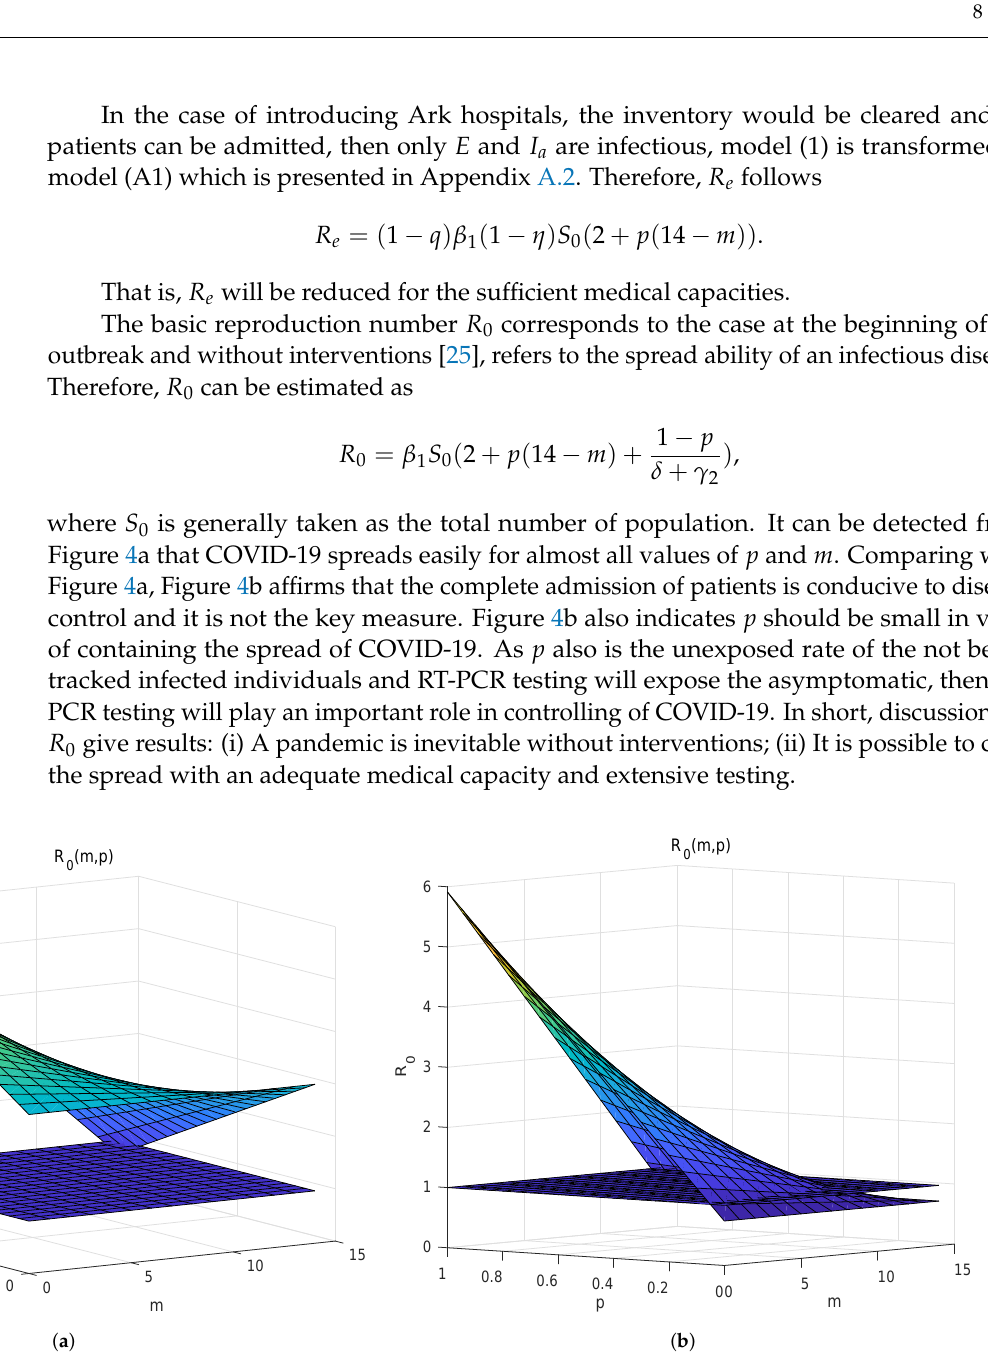
Figure 4: Investigations on the basic reproduction number